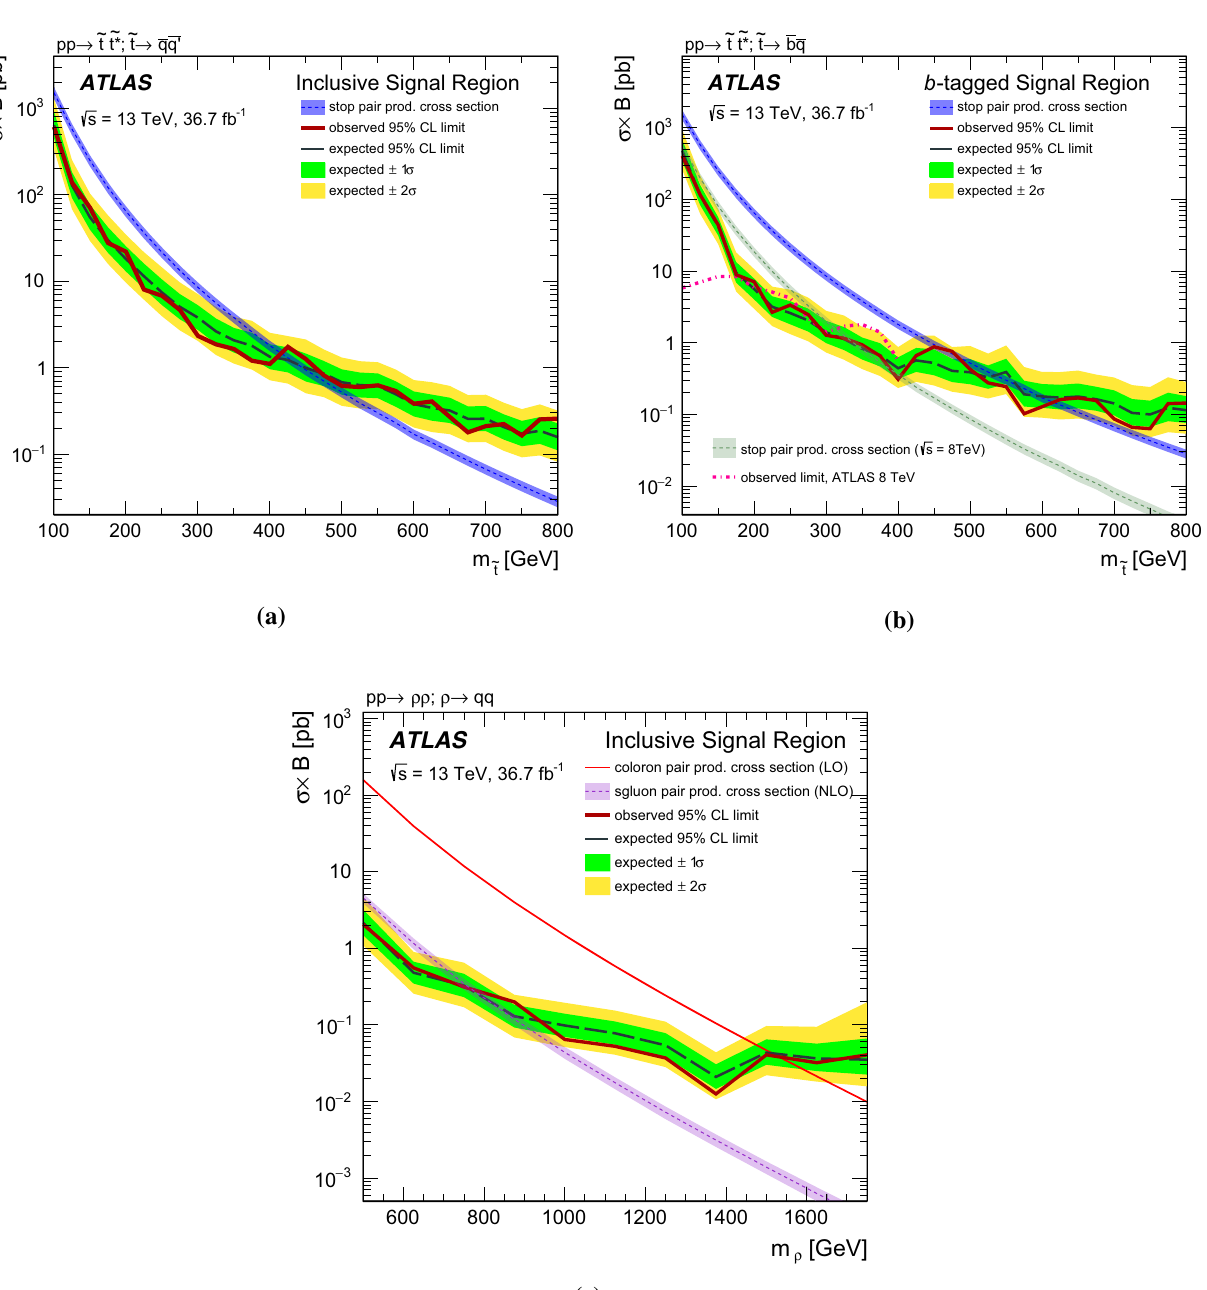
Fig. 9 The 95% CL upper limit on the σ × B value compared to the theoretical cross-section for the direct pair-production of top squarks with decays into a ¯ q ¯ q (cid:3) or b ¯ b ¯ s and c high-mass colorons decaying into qq and sgluons decaying into gg . The dashed black and solid red lines show the 95% CL expected and observed limits respectively, including all uncertainties except the theoretical signal cross-section uncertainty.